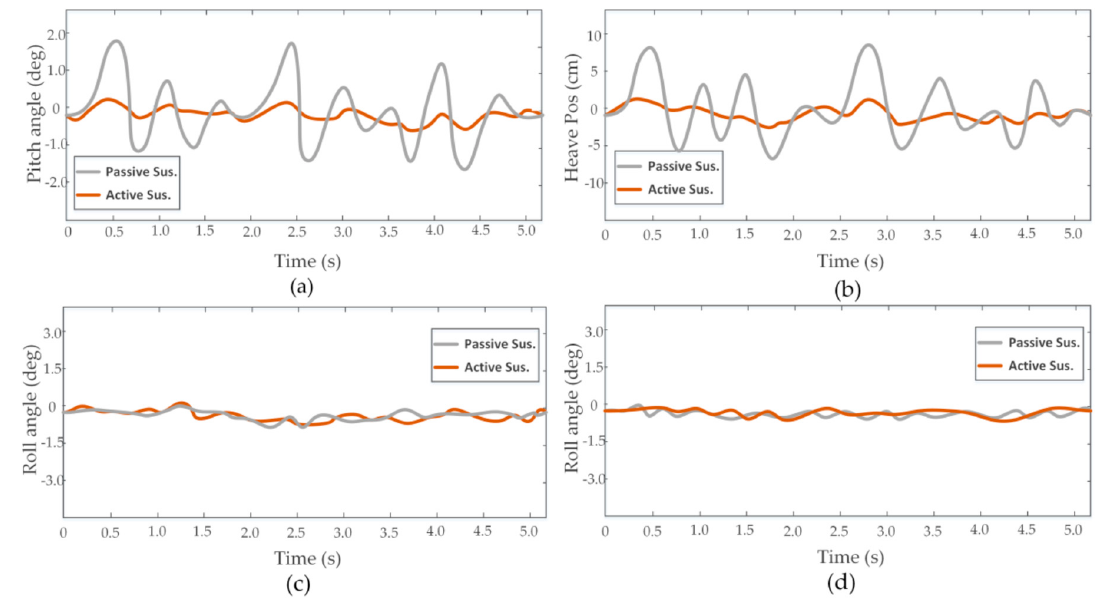
Figure 11. Time domain plots of heave, pitch, roll, and yaw data obtained by sensors. ( a ) Pitch angle. ( b ) Heave position. ( c ) Roll angle. ( d ) Yaw angle.